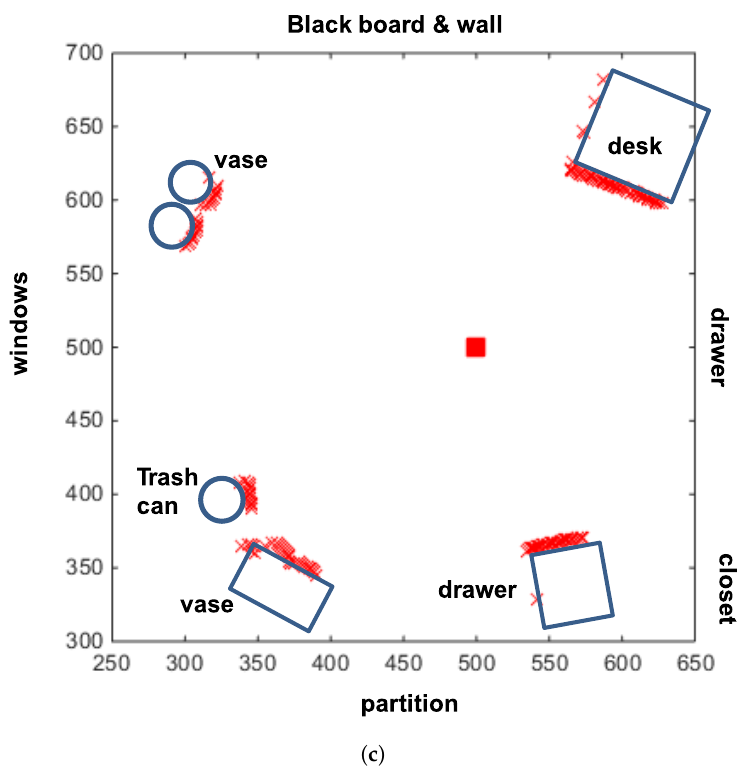
Figure 3. Experimental environment env 0: ( a ) a view of the environment; ( b ) omnidirectional image from the camera; ( c ) distance map from the range sensor; the red square indicates the home position (500,500).